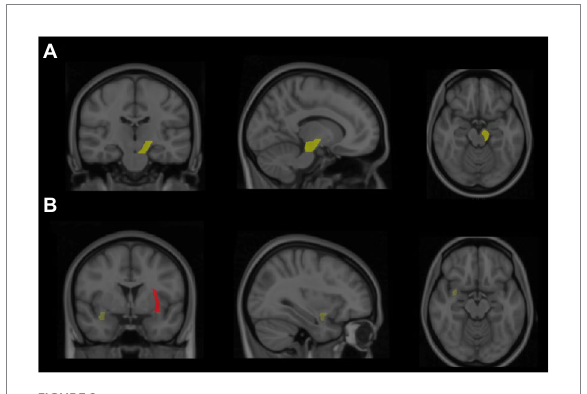
FIGURE 2 Highlight the greater fractional anisotropy (FA) value of brain regions from both Tai Chi and walking groups compared to the sedentary control group. (A) Revealed that the brain region of the Tai Chi group exhibited higher FA value in the left cerebral peduncle. (B) Showed in brain regions that the Tai Chi or walking groups displayed higher FA value in right uncinate fasciculus (yellow) and left external capsule (red),